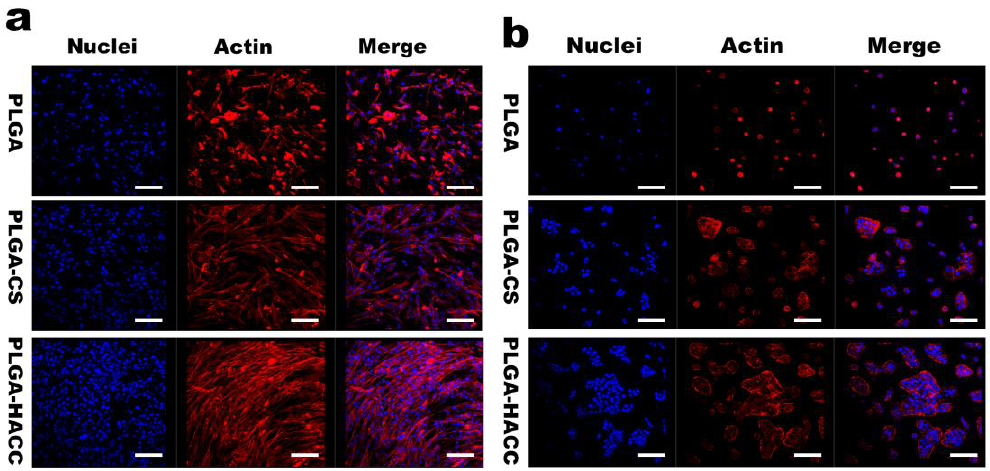
Figure 4. The cytoskeletal morphology of HDFs ( a ) and HaCaTs ( b ) on different fibrous membrane surfaces after incubation for 24 h. Representative images of cells stained with rhodamine-labeled phalloidin for actin filaments (red) and DAPI for nuclei (blue). The scale bar is 50 μm.